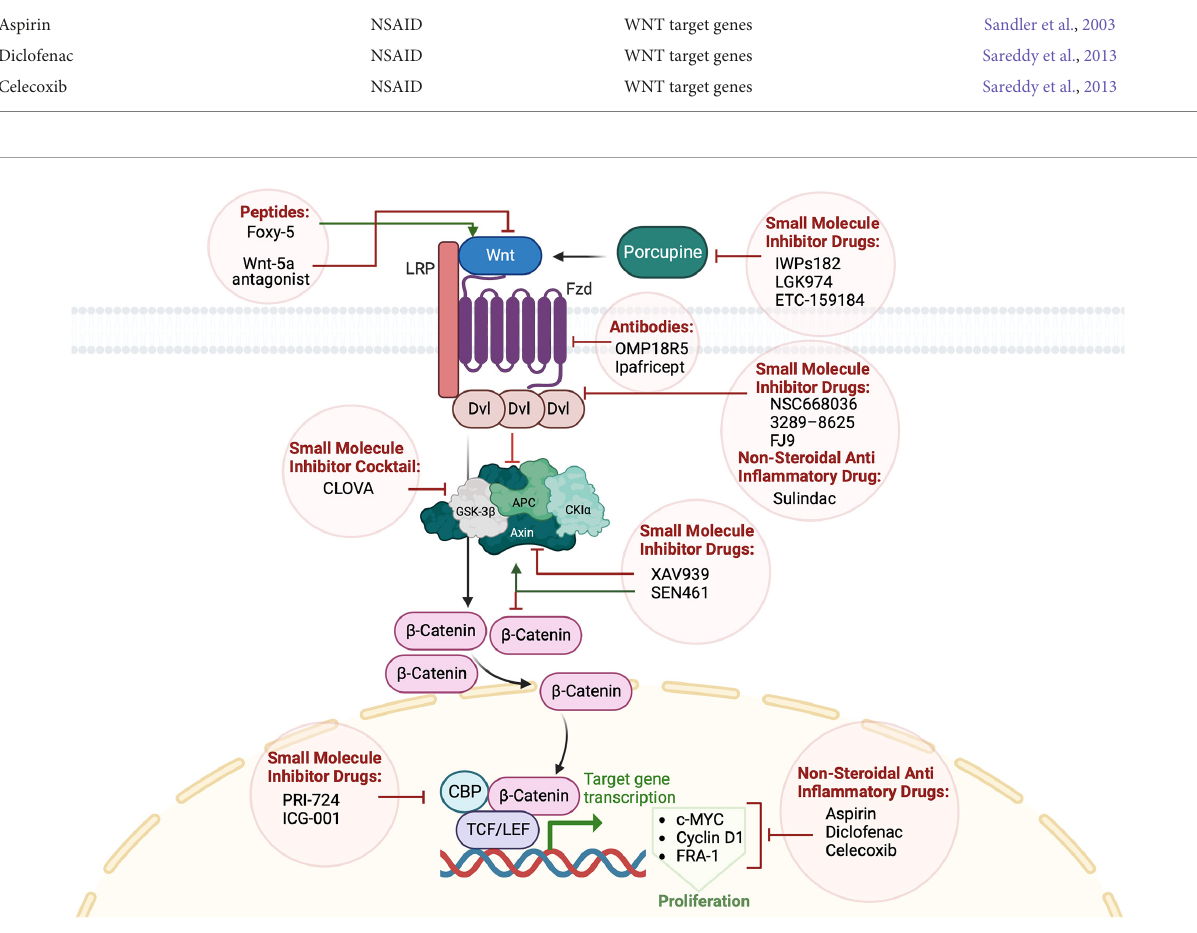
FIGURE3 Targeting WNT signaling in glioblastoma therapy. Small inhibitors target WNT secretion, components of the destruction complex, or activity of the transcription machinery. Non-steroidal anti-inflammatory drugs inhibit cellular proliferation promoted by β -catenin downstream targets. Anti-Frizzled antibodies inhibit the activation of WNT